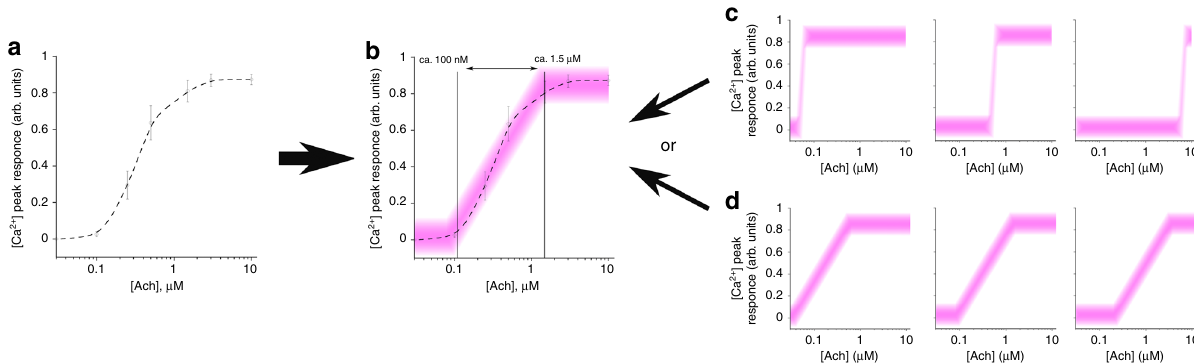
Fig. 1 Population and individual cell responses. a Population of HEK293 cells elicits an intracellular Ca 2+ response to increasing concentrations of acetylcholine (Ach). Data are provided from cell responses averaged over four independent experiments, randomly selected from the full data set, 20 – 30 cells in each experiment, as mean ± sem. b This response has a certain dynamic range (marked by the vertical lines and double arrow), where the response strength is proportional to Ach concentration. c , d Two scenarios behind this population response can be envisioned. In the fi rst c , each cell may possess a sharp threshold of a “ yes-or-no ” response, shifted differently along the agonist concentration scale. Alternatively d , each cell has its own dynamic range, also shifted differently along the agonist concentration scale. Broadness of the pink lines schematically illustrates the noise in the individual cell responses, provided by deviations from the mean response strength in the experiment whereby cells are stimulated